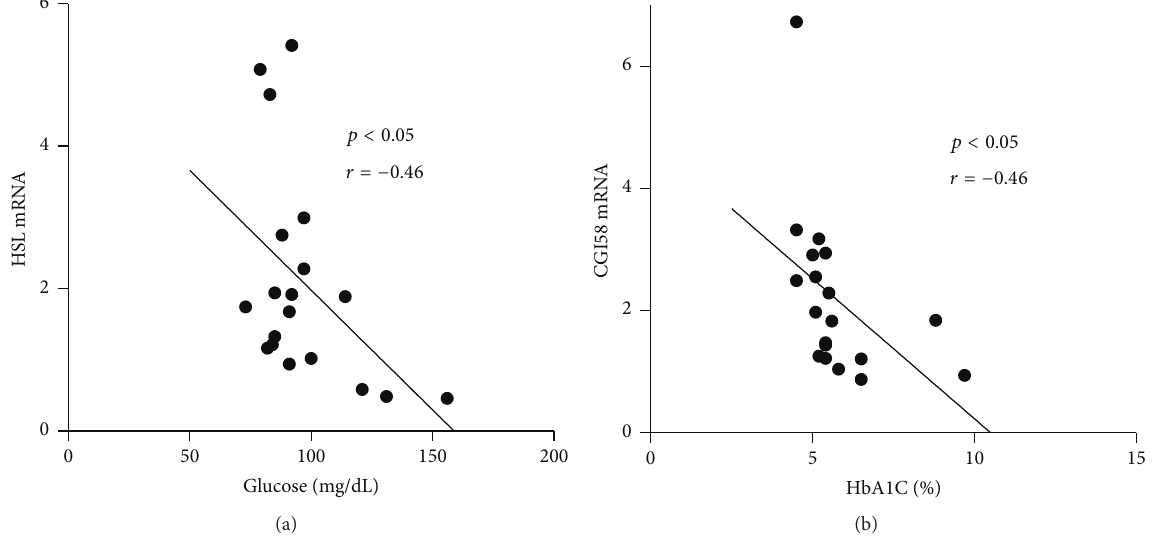
Figure 3: Associations between HSL, CGI-58 mRNA, and clinical parameters. (a) HSL mRNA expression negatively correlated with fasting blood glucose level after weight loss ( 𝑝 < 0.05 , 𝑟 = −0.46 ). (b) CGI-58 mRNA was negatively associated with HbA1C ( 𝑝 < 0.05 , 𝑟 = −0.46 ).